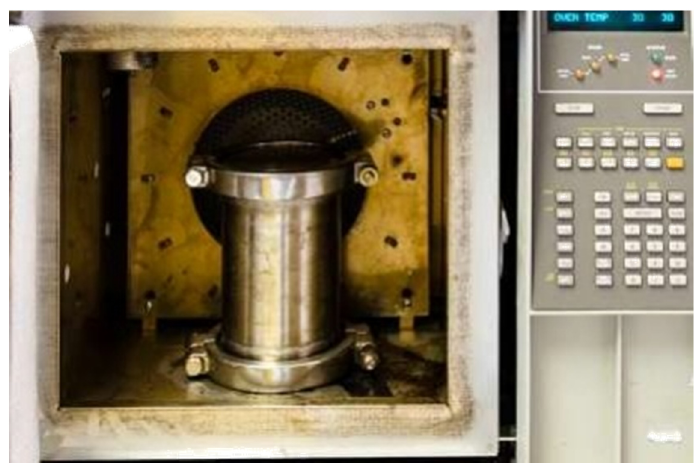
Figure 2. One liter tank in oven (Hewlett Packard 5890 GC) ready for heating.